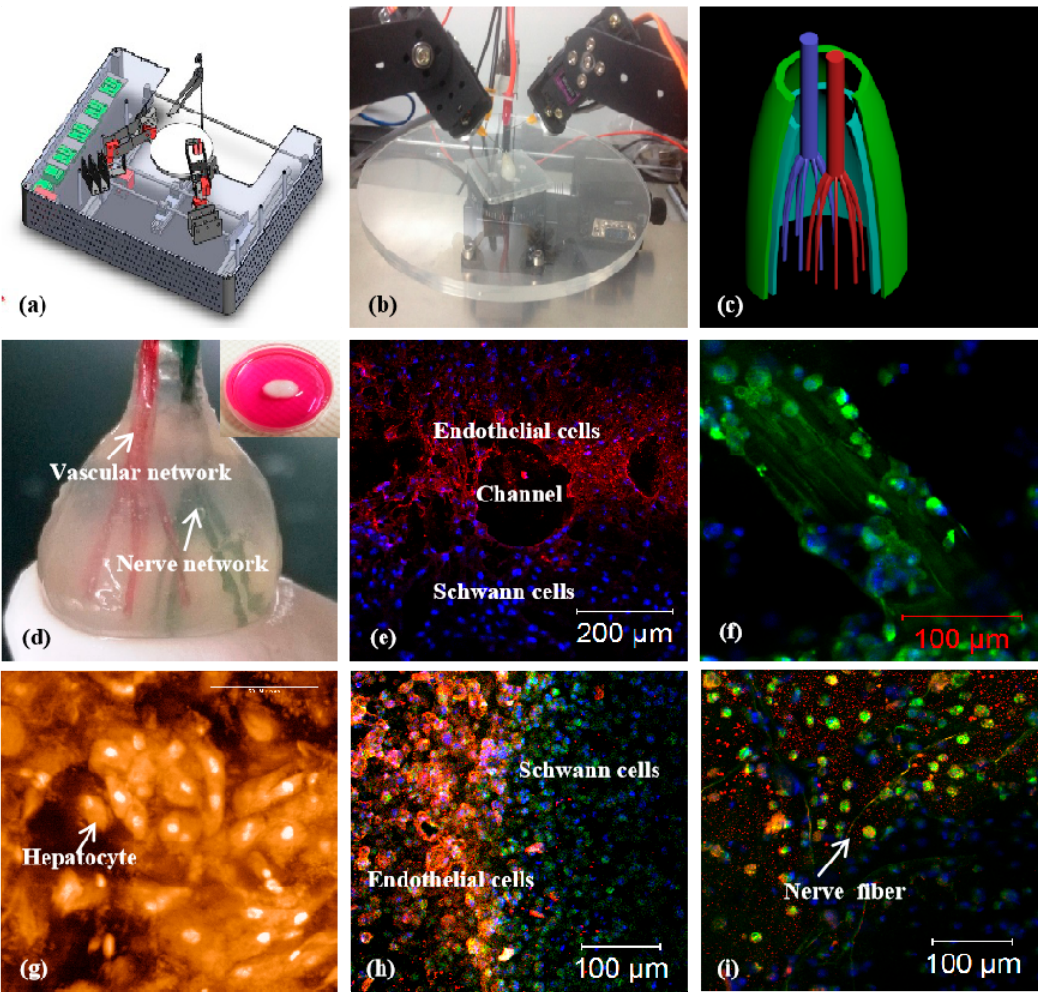
Figure 14. A combined four-nozzle organ three-dimensional (3D) printing technology created in Tsinghua University, Prof. Wang’ laboratory in 2013: ( a ) equipment of the combined four-nozzle organ 3D printer; ( b ) working state of the combined four-nozzle organ 3D printer; ( c ) a computer-aided design (CAD) model representing a large scale-up vascularized and innervated hepatic tissue; ( d ) a semi-ellipse 3D construct containing a poly (lactic acid-co-glycolic acid) (PLGA) overcoat, a hepatic tissue (made from hepatocytes in the gelatin/chitosan hydrogel), a branched vascular network (with a fully confluent endothelialized adipose-derived stem cells (ASCs) on the inner surface of the gelatin/alginate/fibrin hydrogel) and a hierarchical nervous (or innervated) network (made from Schwann cells in the gelatin/hyaluronate hydrogel), the maximal diameter of the semi-ellipse can be adjusted from 1 mm to 2 cm according to the CAD model; ( e ) a cross section of ( d ), showing the endothelialized ASCs and Schwann cells around a branched channel; ( f ) a large bundle of nerve fibers formed in ( d ); ( g ) hepatocytes underneath the PLGA overcoat; ( h ) an interface between the endothelialized ASCs and Schwann cells in ( d ); ( i ) some thin nerve fibers [164].